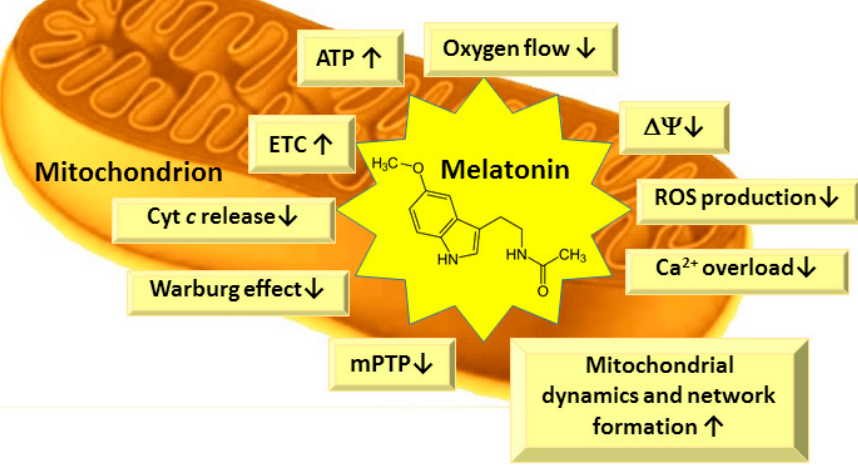
Figure 4. Main biological effects of melatonin in mitochondria. ETC—electron transport chain; ∆Ψ —mitochondrial membrane potential; ROS—reactive oxygen species; mPTP—mitochondrial permeability transition pore; Cyt—cytochrome.